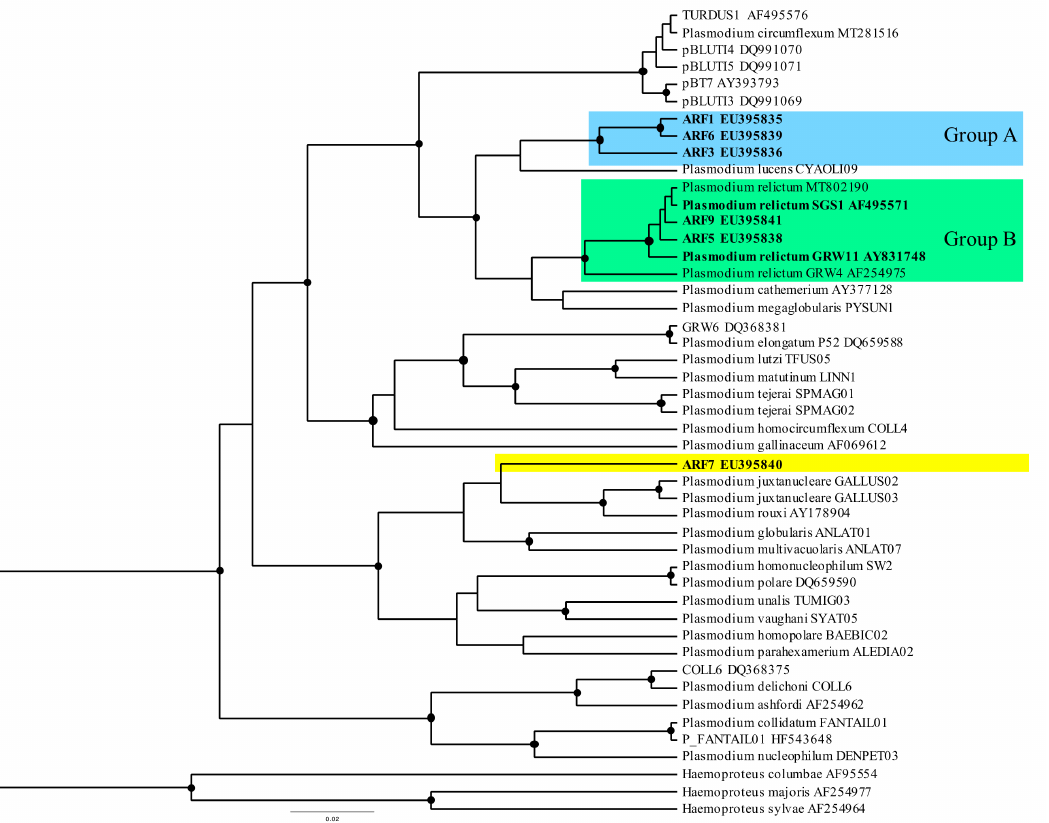
Figure 2. Phylogram of Plasmodium spp. cytochrome b lineages found in Alectoris rufa sampled in central Spain. Lineages detected in this study are shown in bold. Principal groups are indicated by colours and correspond to closely related lineages that belong, or likely belong, to the same parasite morphospecies. Haemoproteus majoris , H. columbae and H. sylvae were used as outgroups. Bayesian posterior probabilities above 0.5 are depicted (black dots) at each node. GenBank accession numbers or MalAvi database morphospecies are indicated after lineage